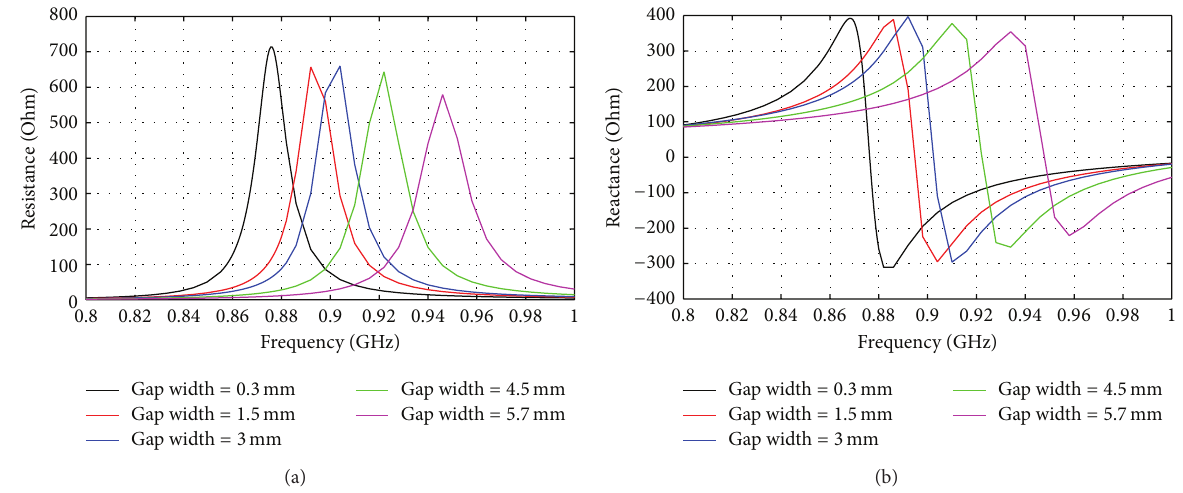
Figure 12: Tuning the real and imaginary parts of the input impedance by varying the width of the coupling gap.